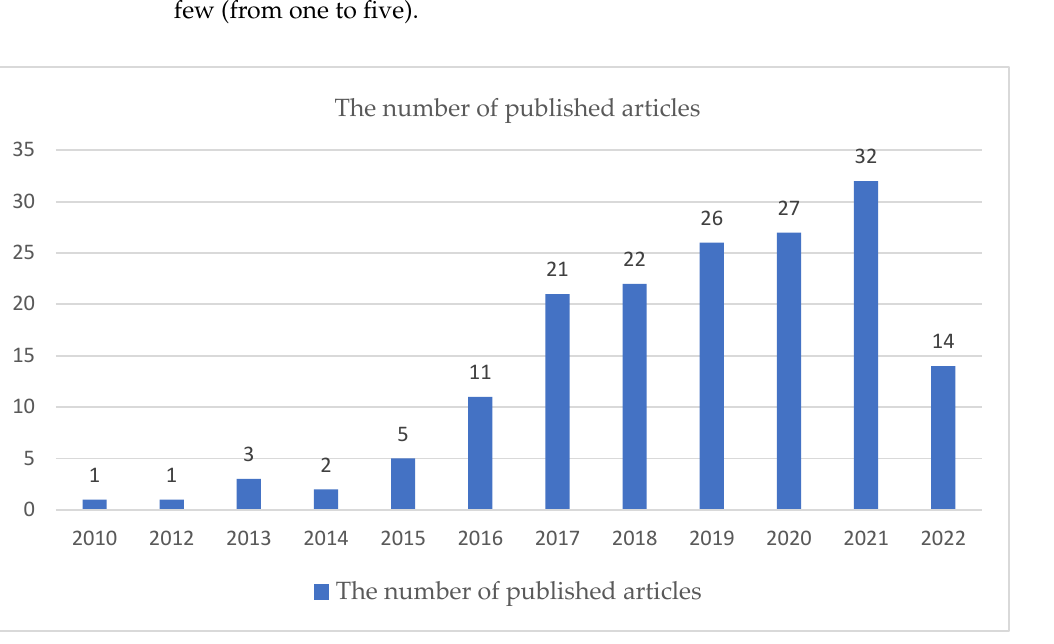
Figure 2. Number of reviewed articles per year.